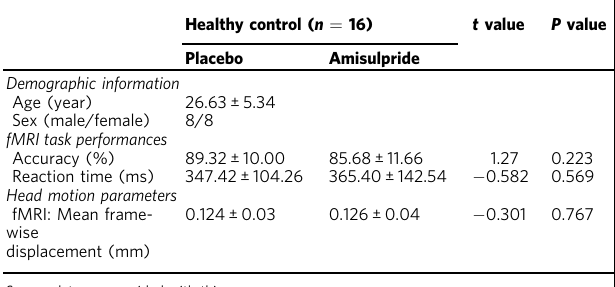
Table 2 Sample characteristics for the pharmacological intervention